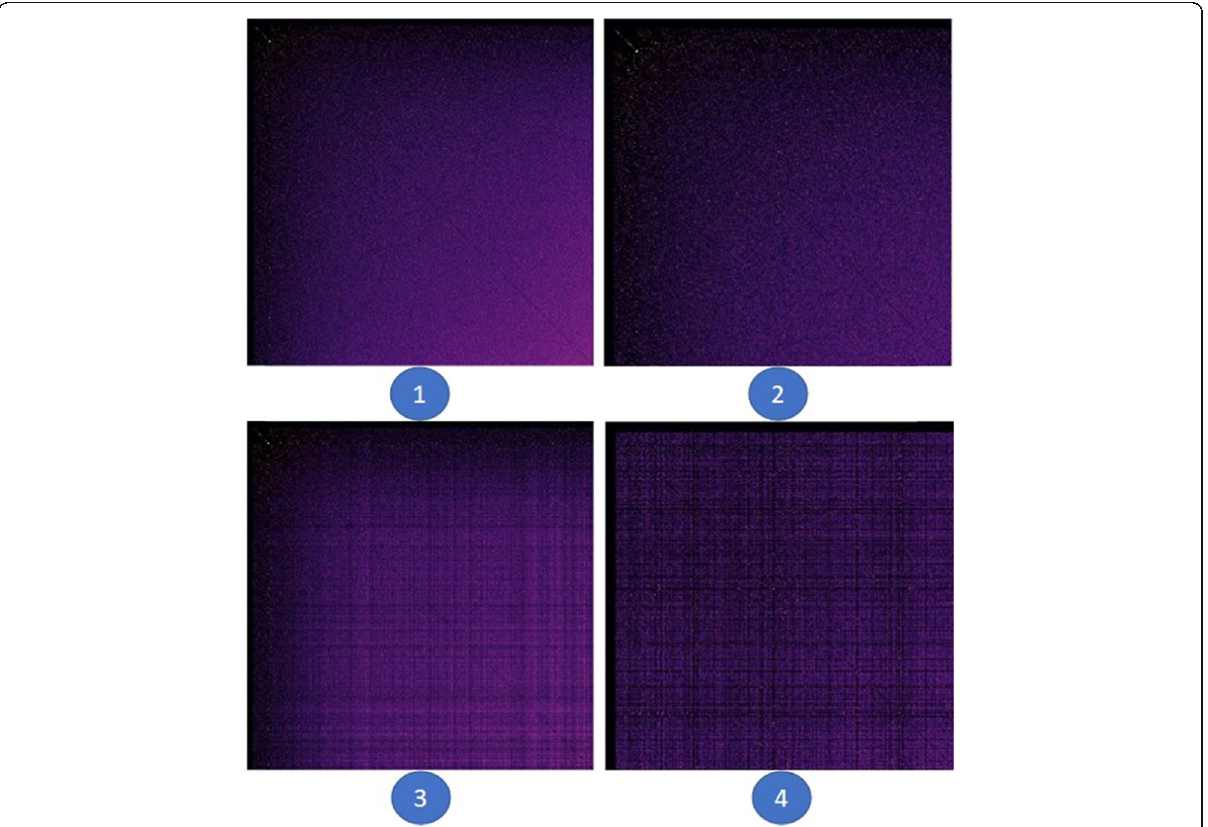
Fig. 13 Matrices of the author-similarity dataset reordered using the (1) mean value ordering, (2) weight sum ordering, (3) unique value ordering, and (4) shortest path ordering